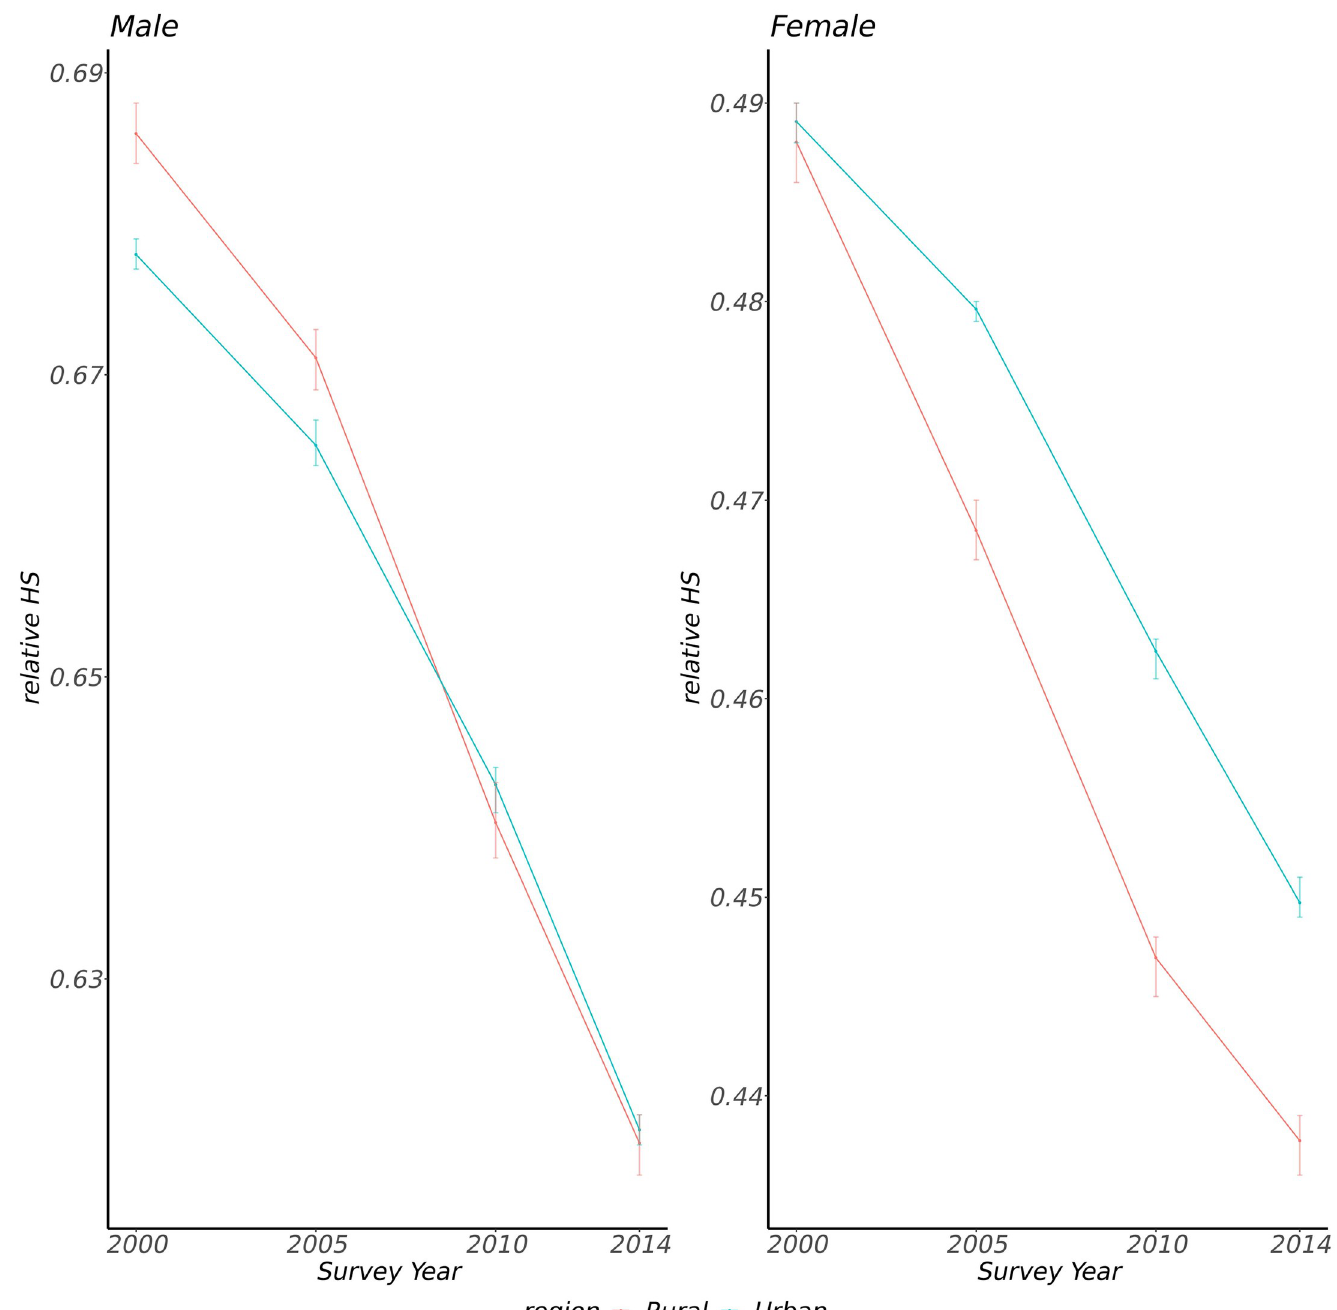
Fig 2. The medians with 95% confidence intervals of relative HS in rural or urban areas in four survey years (error bars represent 95% confidence intervals for medians).